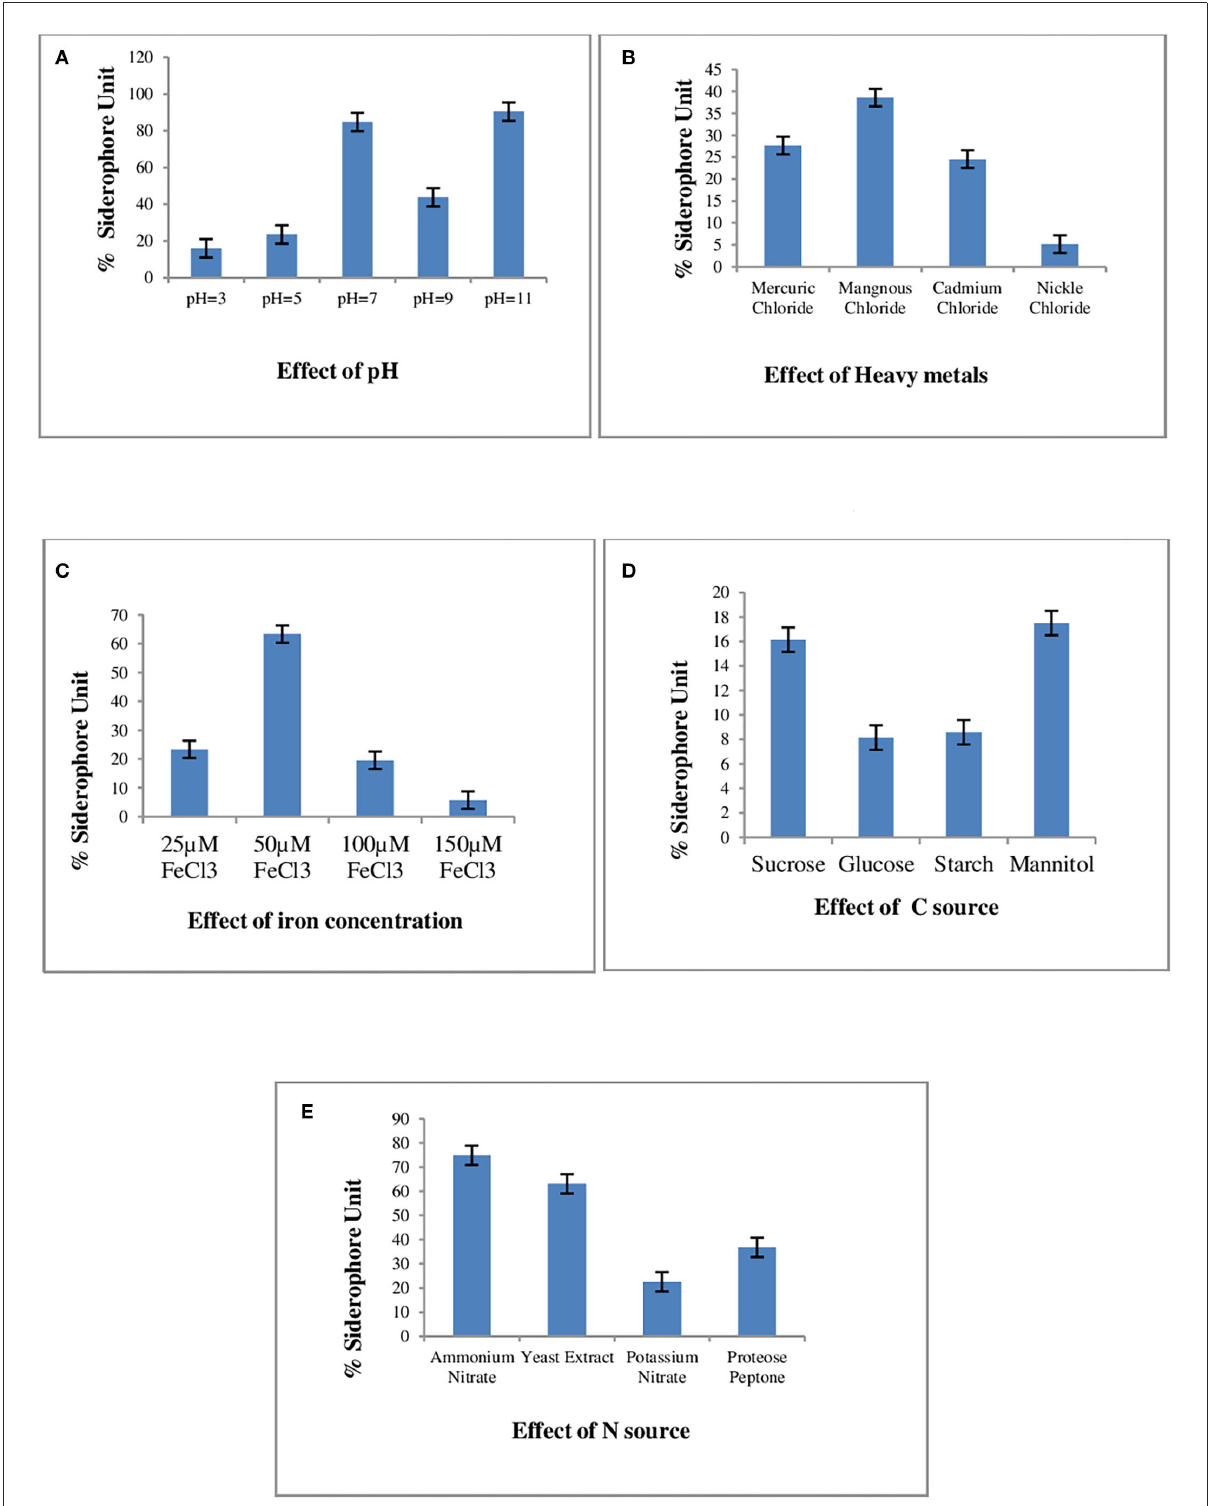
FIGURE1 Effect of various culture conditions on Siderophore Production in P. monteilli strain B8 (MN759447). The succinate broth was inoculated with log phase of strain P. monteilli strain B8 (MN759447) and incubated at 37 ◦ C for 48–72h at 120 rpmand amended separately with different heavy metals, carbon source, nitrogen source, Fe concentration and at different pHs. The %SU was calculated using formula = Ar – As/Ar × 100